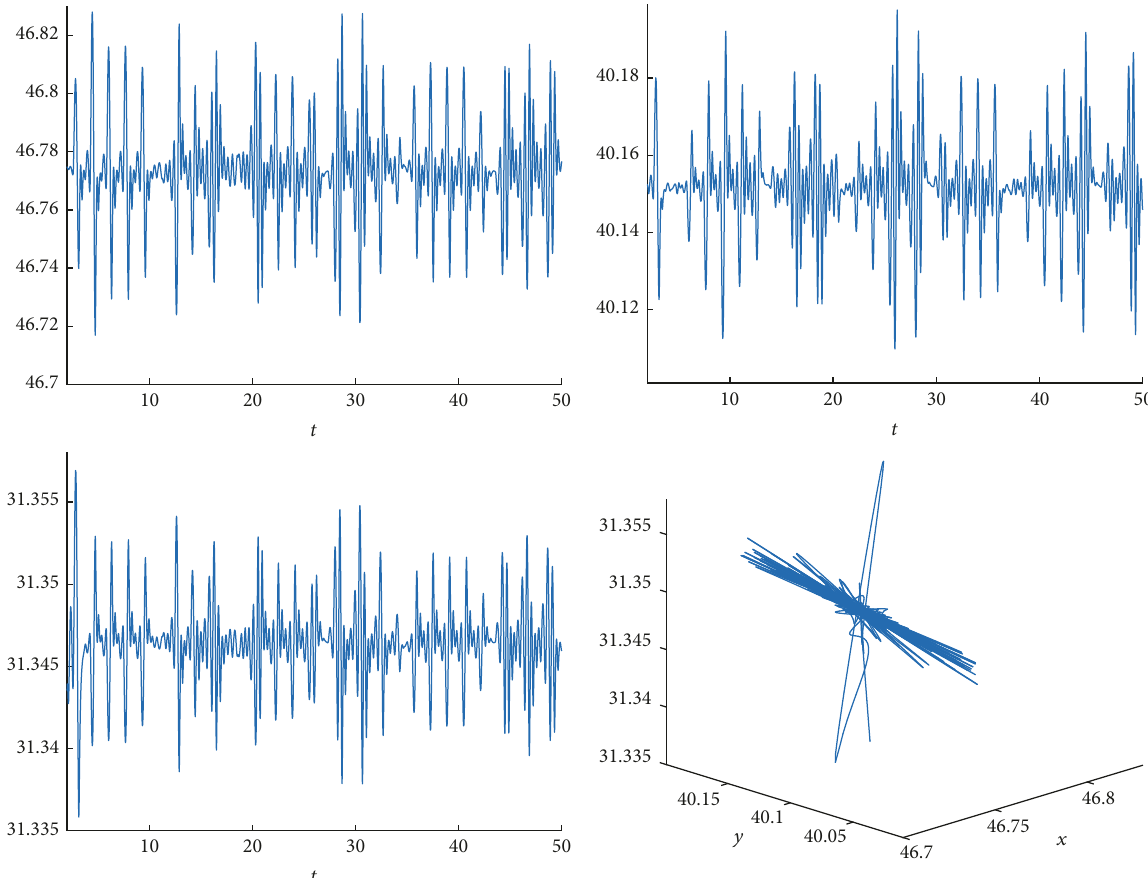
Figure 2: Dynamical behaviors and phase space trajectories of the three fish